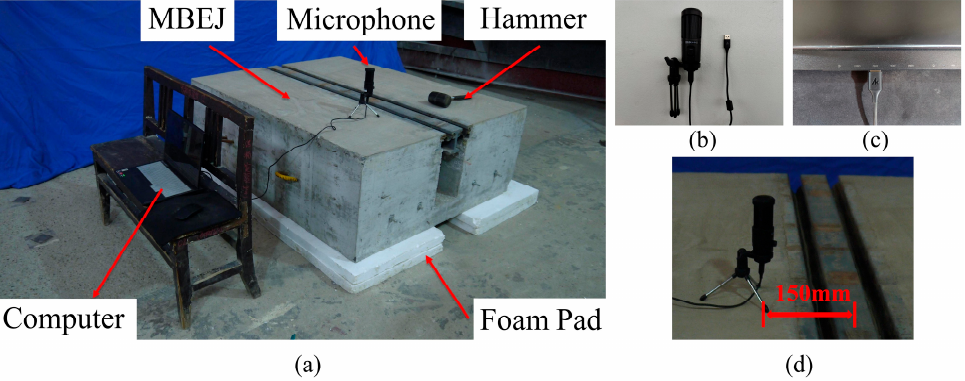
Figure 3. Experimental details: ( a ) experimental process; ( b ) microphone; ( c ) interface for computer and microphone connection; ( d ) location of the microphone. and microphone connection; ( d ) location of the